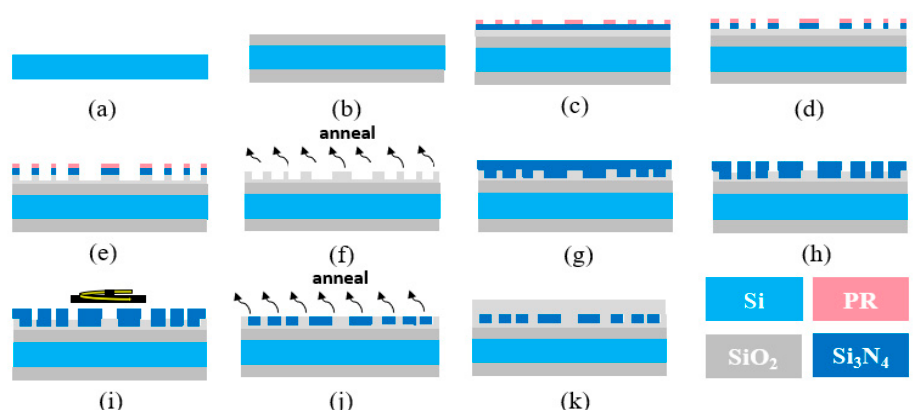
Figure 7. The fabrication process flow of the Si 3 N 4 waveguide. ( a ) wafer start on a 8-inch wafer; ( b ) BOX layer deposition; ( c ) HM deposition and lithography; ( d ) HM etch; ( e ) BOX layer etch; ( f ) BOX layer anneal; ( g ) core layer deposition; ( h ) reverse etch; ( i ) CMP; ( j ) core layer anneal; ( k ) cladding layer deposition.